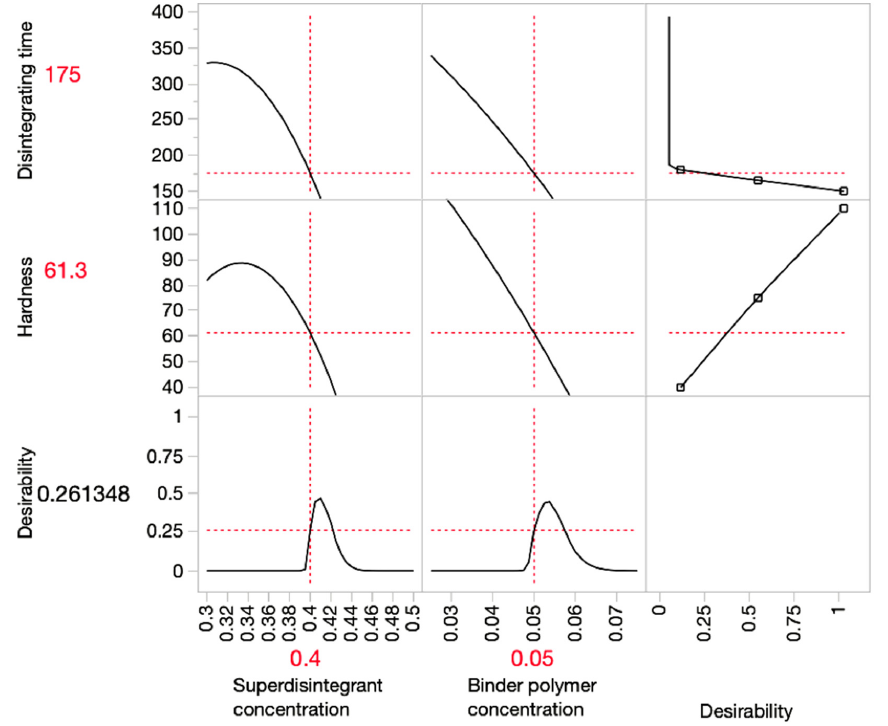
Figure 5. Prediction profiler graph for predicting the optimal formulation considering both disinte- grating time and hardness. Table 10. Characterisation results of F2a and F2b compared with